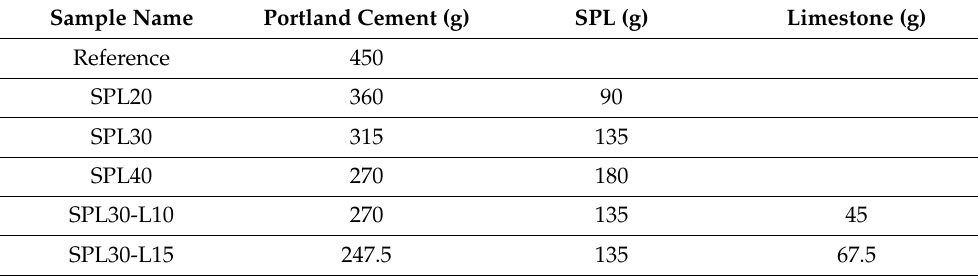
Table 1. Binder mixtures for strength